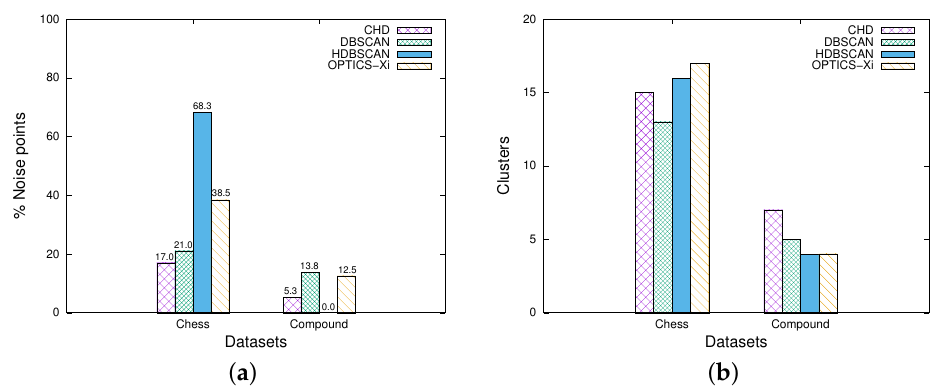
Figure 7. Number of noise points ( a ) and number of clusters ( b ) detected by the four algorithms on the two datasets.